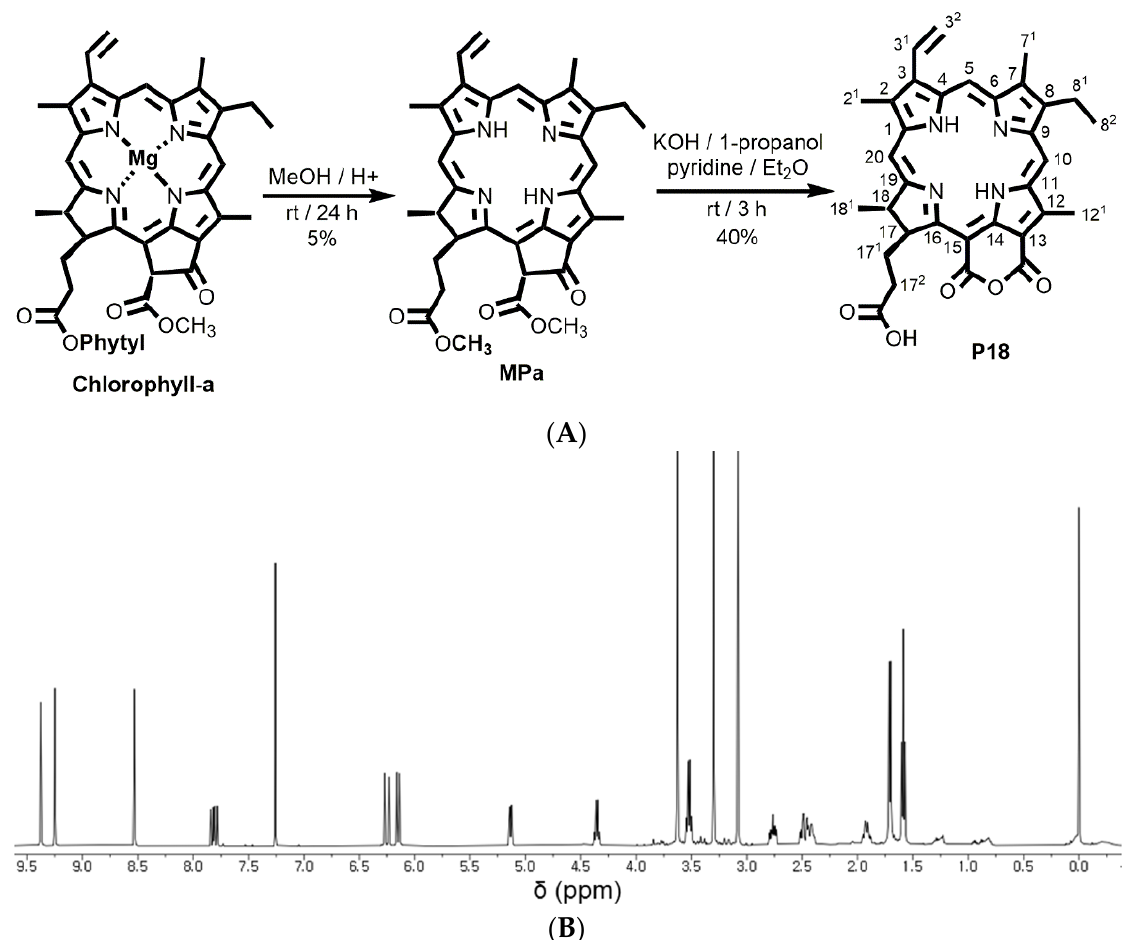
Figure 1. ( A ) Schematic representation of the synthesis of P18 from chlorophyll-a through MPa with numbering, ( B ) 1 H-NMR spectrum of P18 (500 MHz, CDCl 3 , 25 °C, TMS).